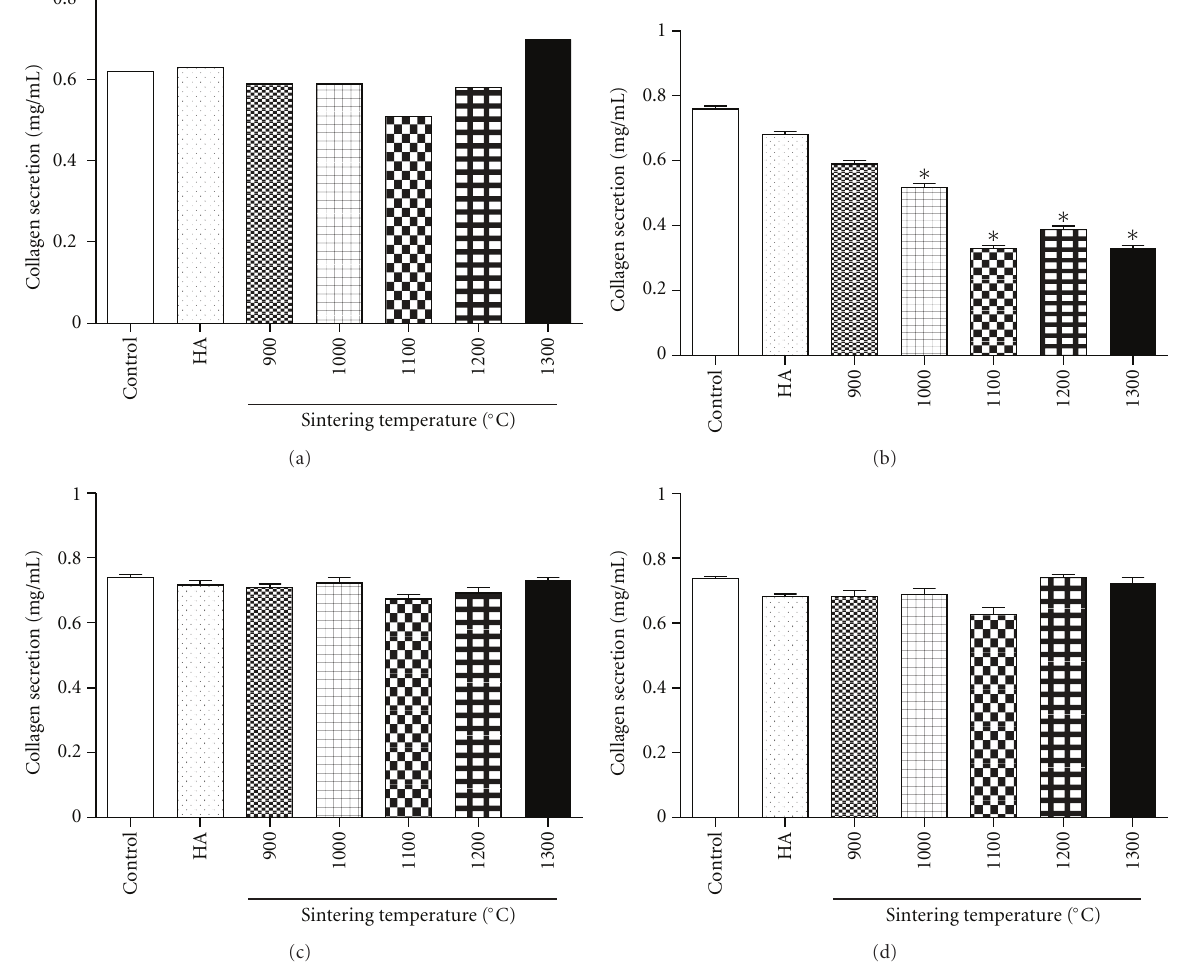
Figure 3: Collagen secretion of osteoblasts cultured in the presence of di ff erent concentrations of LiHA. (a) 0.25% LiHA, (b) 0.50% LiHA, (c) 1.0% LiHA, and (d) 2.0% LiHA. The results are expressed as the means ± SD, ( ∗ ) indicating a significant di ff erence comparing to control with P < 0 .